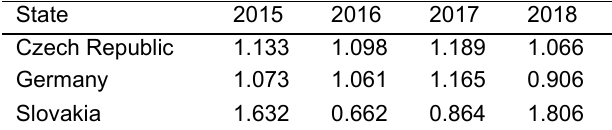
Table 2. Growth index of drivers' remuneration in road freight